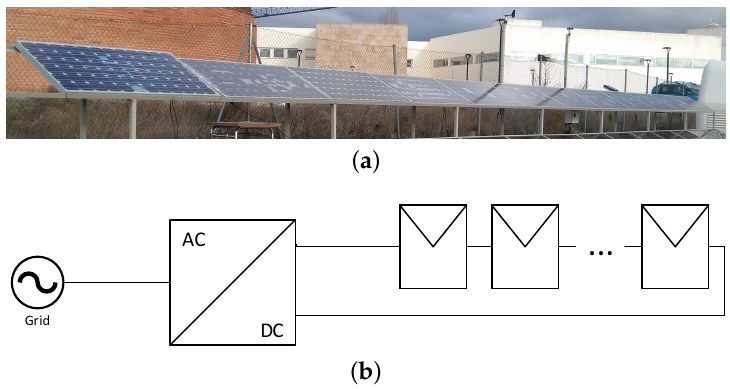
Figure 6. Panels with several defects used in the pilot plant ( a ), and connection diagram between panels and the inverter ( b ).